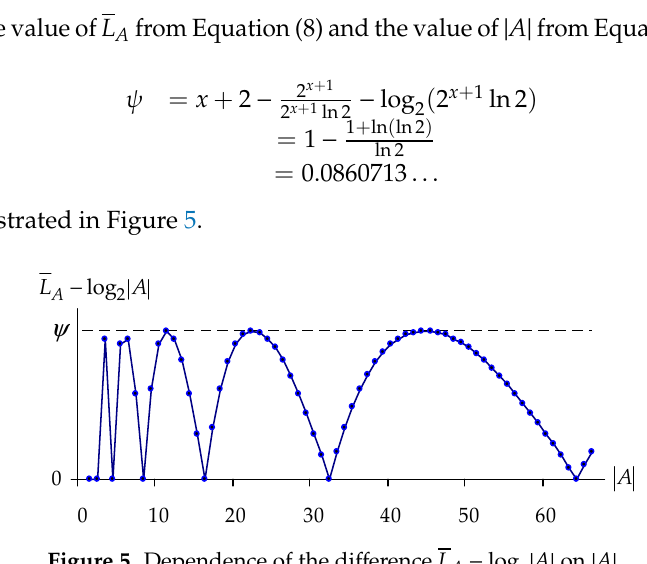
Figure 5. Dependence of the di ff erence L A − log